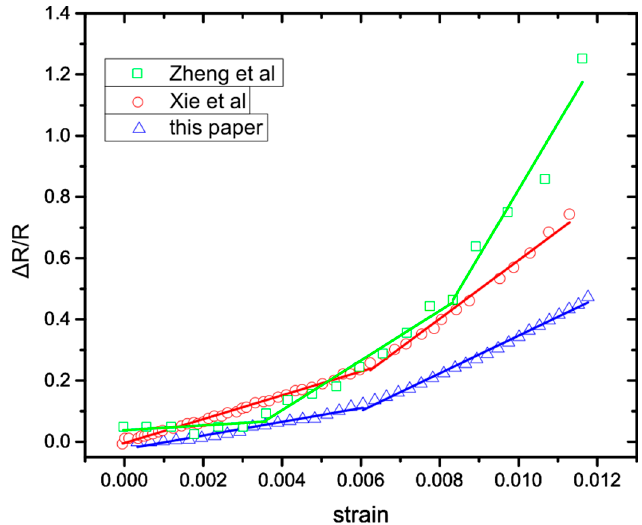
Figure 6. Relative resistance change over strain for different strain sensors based on sputtering deposited NPs. Zheng et al. [35] Cr NPs-based sensor, Xie et al. [36] Pd NPs -based sensor and this paper with Pt NPs. The solid-colour lines are the fitting of Equations (4) and (9) in the case of strain sensing devices, exhibiting two distinctive linear regions and the fitting of Equations (4), (9) and (12) for strain sensors with 3 different linear regions.